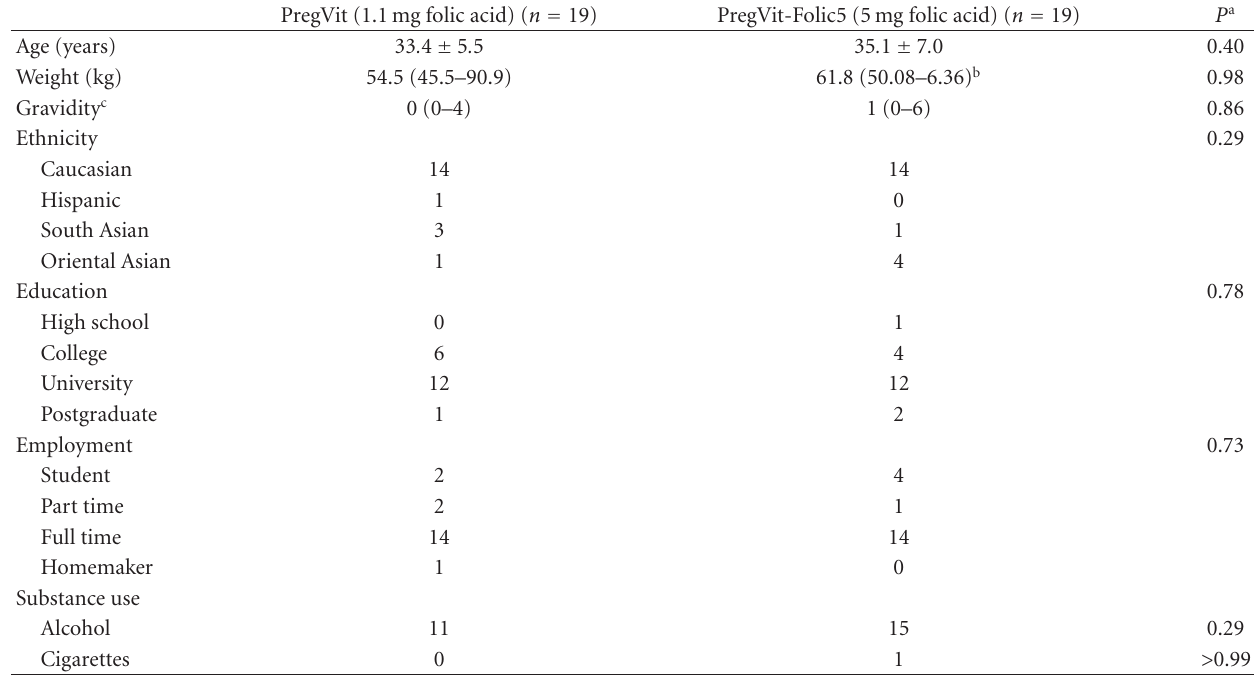
Table 2: Patient characteristics.